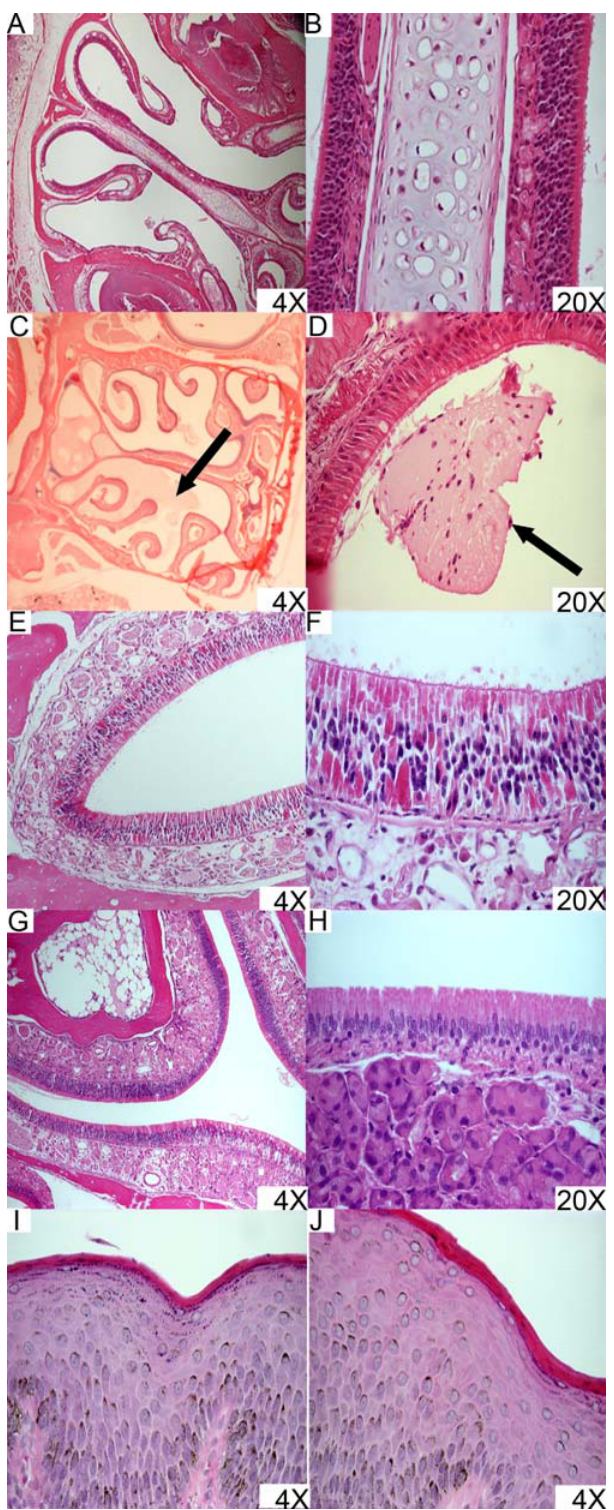
Figure 9. Histopathological analysis of nasal tissue exposed to NE adjuvant or HBsAg-NE. Mice: CD-1 mice were vaccinated with HBsAg-NE and primed at 2 weeks. (A–B) Photomicrographs of H&E stained nasal epithelium collected from mice 14 days following the boost vaccination. Only normal tissue architecture was recorded which indicates a lack of (sub) chronic cytotoxicity or inflammation. (C) Nasal epithelium collected 24 hours following boost vaccination with